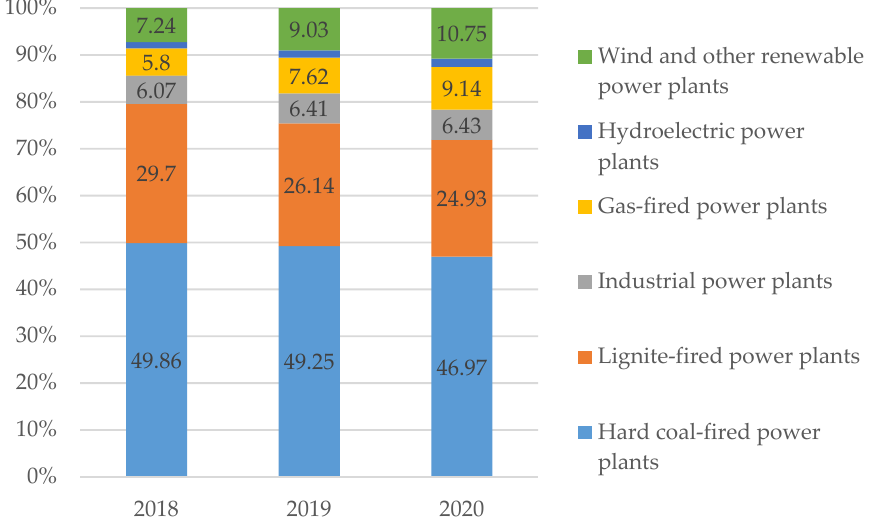
Figure 3. Electricity generation by power plants in Poland according to fuel type, 2018–2020 (source: own elaboration, based on: PSE data).